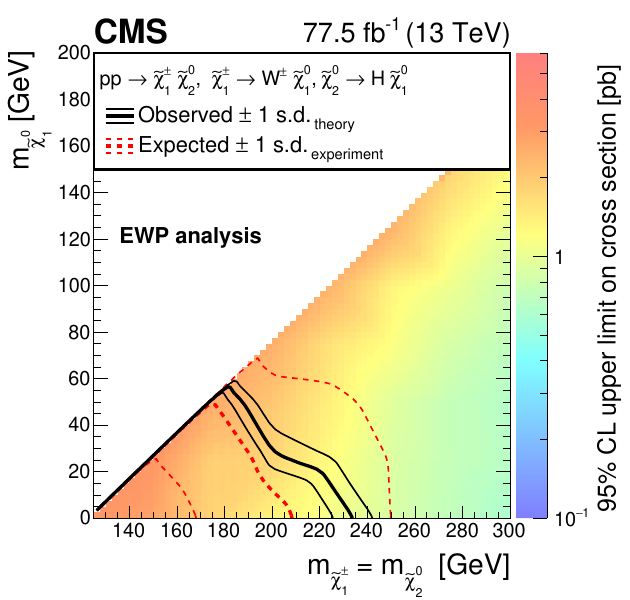
Figure 4 . The observed 95% CL upper limits on the wino-like chargino-neutralino production cross section are shown for the EWP analysis. The bold and light black contours represent the observed exclusion region and the (cid:6) 1 standard deviation (s.d.) band, including both experimental and theoretical uncertainties. The analogous red dotted contours represent the expected exclusion region and its (cid:6) 1 s.d. band.